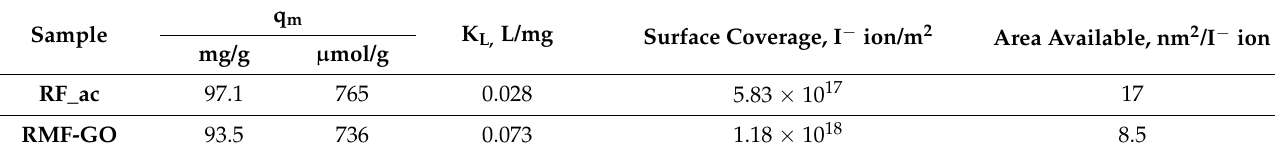
Table 7. Modeling